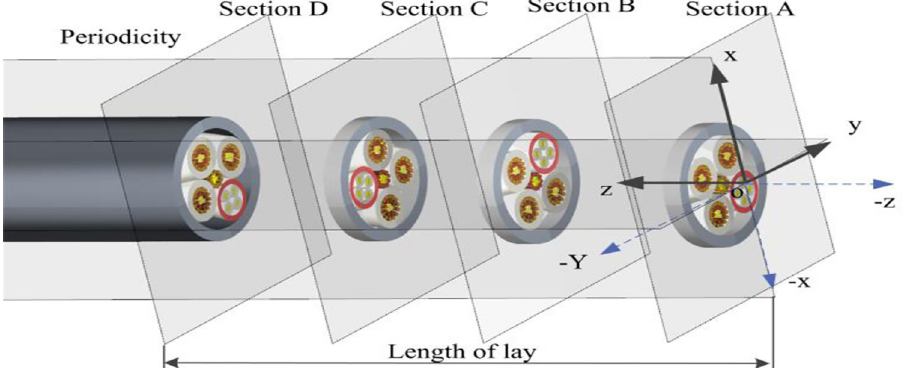
Fig 7. Schematic diagram of orthotropic elastic model of